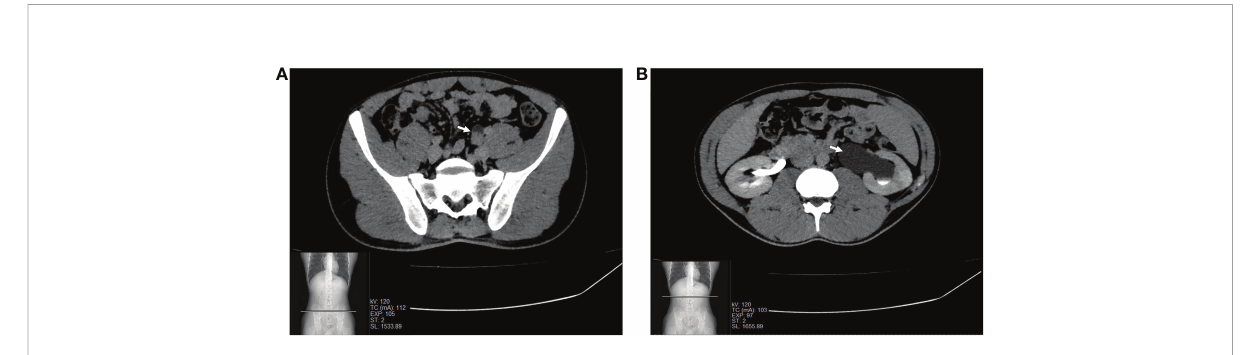
FIGURE 1 CT scan of the urological tract scan showing the narrowed lumen of the left pelvic ureter (A) and ipsilateral hydronephrosis (B)